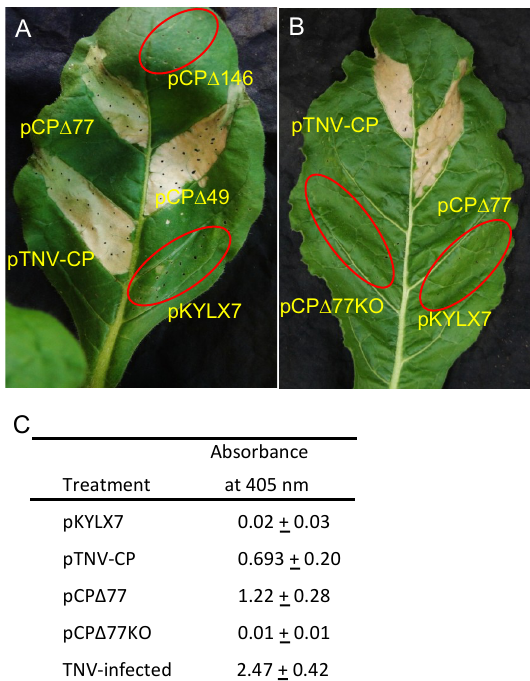
Figure 3. Agroinfiltration of pTNV-CP, N-terminal TNV CP deletion mutants, and empty vector pKYLX7 into N. langsdorffii at 3 dai. A. Analysis of TNV-CP and three deletion mutants. B. Analysis of TNV-CP, pCP∆77 and pCP∆77KO. C. ELISA values assessed at 405 nm for expression of TNV CP constructs. Leaf panels infiltrated with constructs that do not react with HR are circled in red.